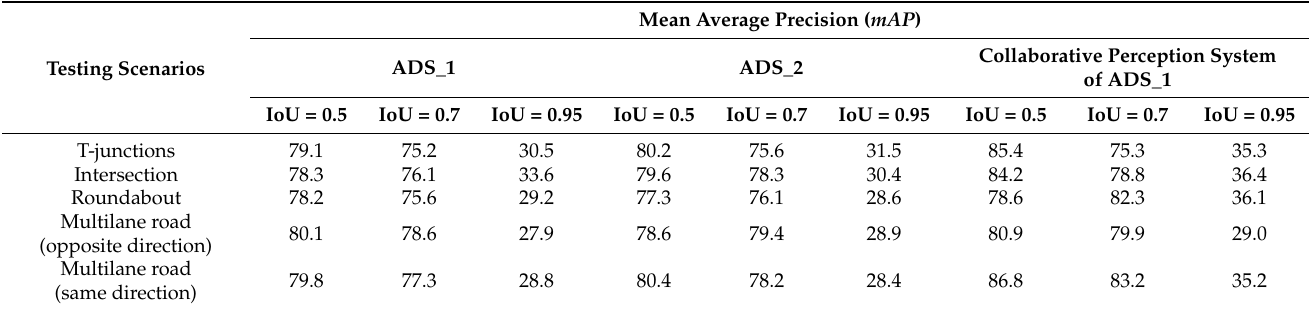
Table 1. The detection performance of individual perception systems of ADS_1, ADS_2 vs. collabora- tive perception